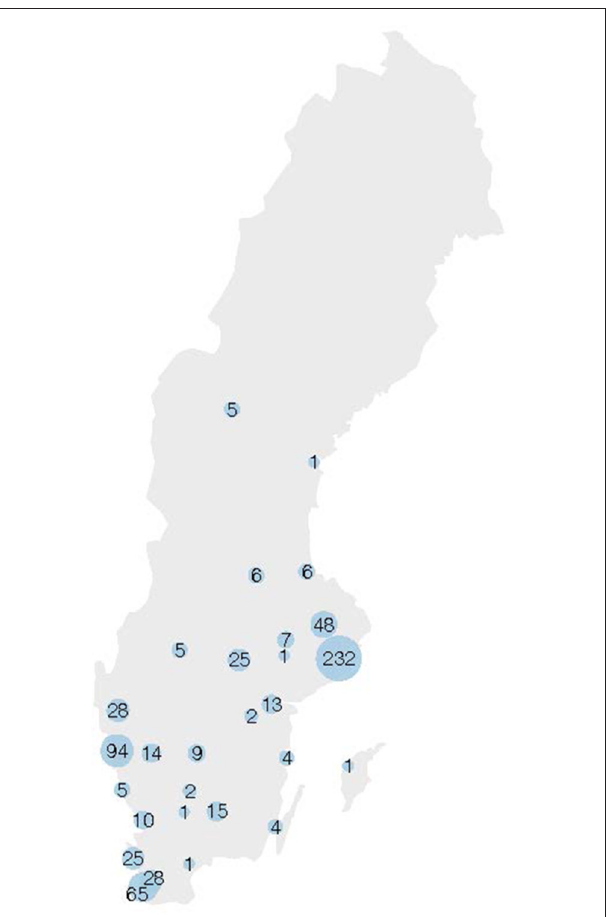
FIGURE 6 | Cases of reported penetrating trauma with ISS ≥ 15 are plotted on a map of Sweden. The size of the blue dots correlates to the number of cases. ISS, Injury Severity